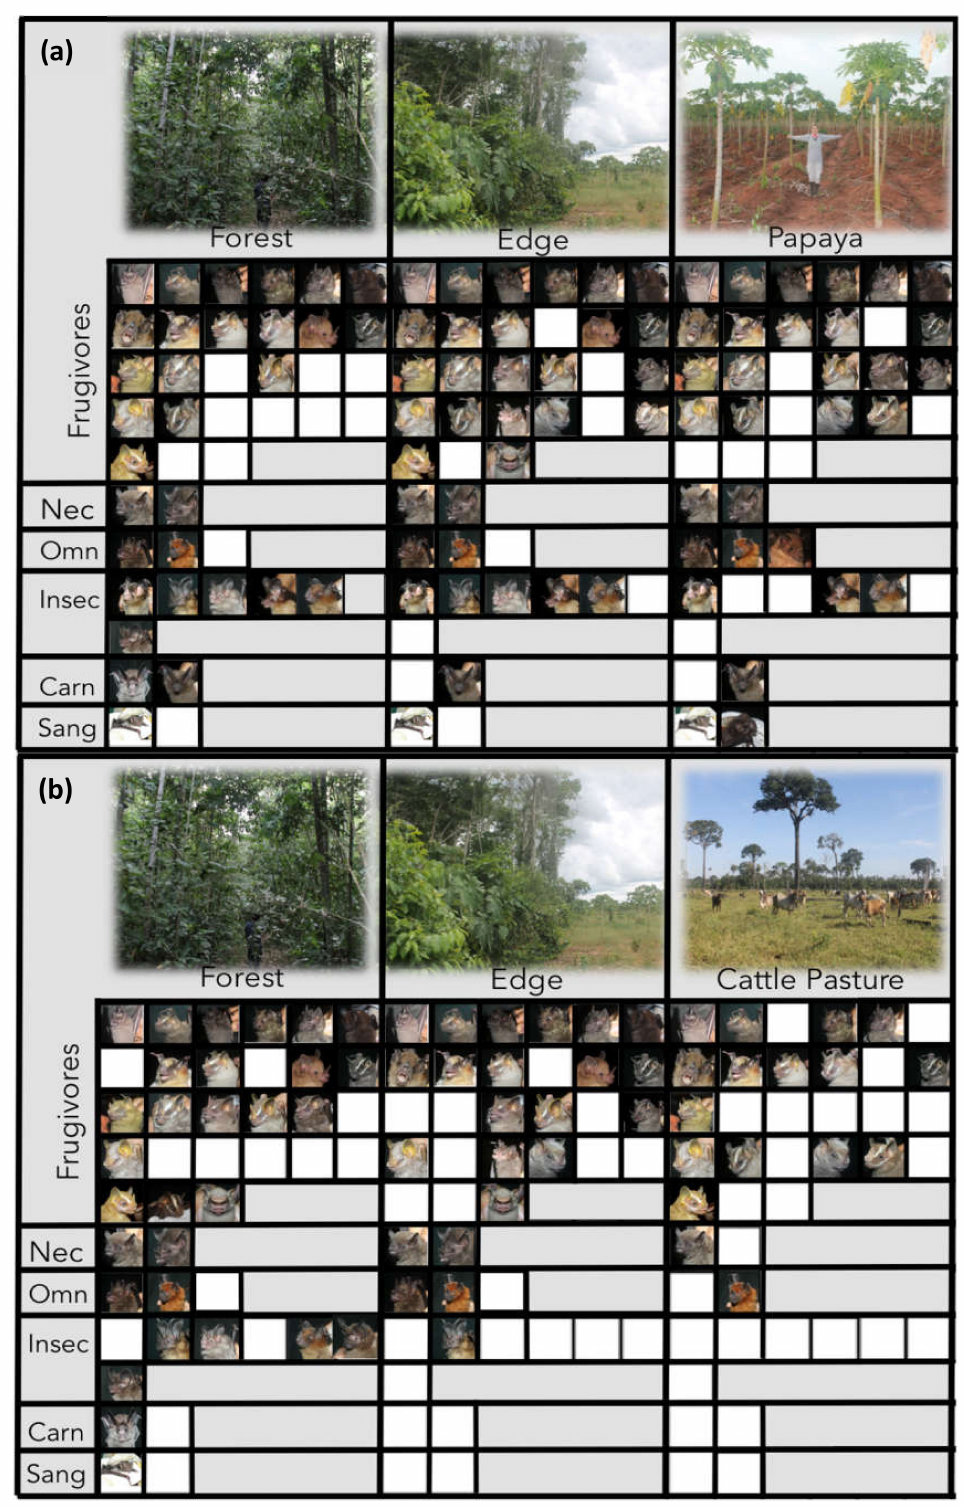
Figure 7. Graphs show the presence and absence of phyllostomid species per trophic guilds at di ff